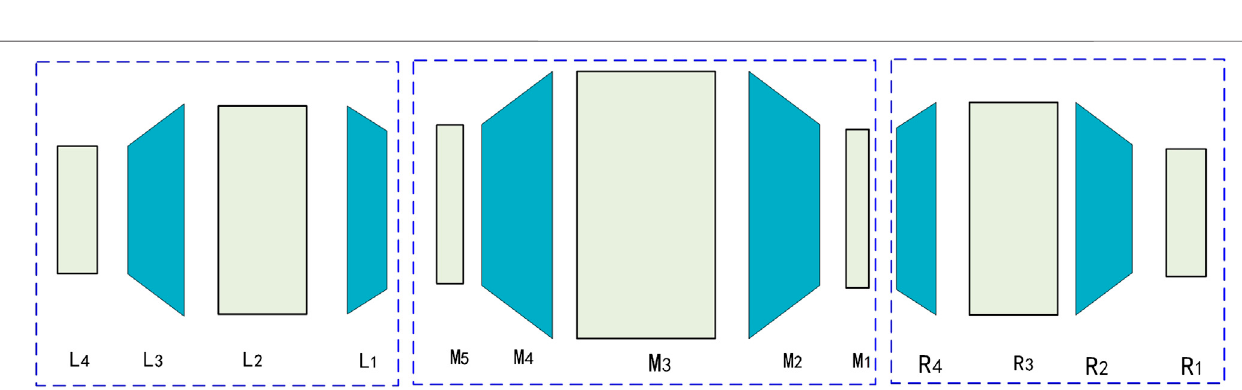
FIGURE 8 | Discrete model of